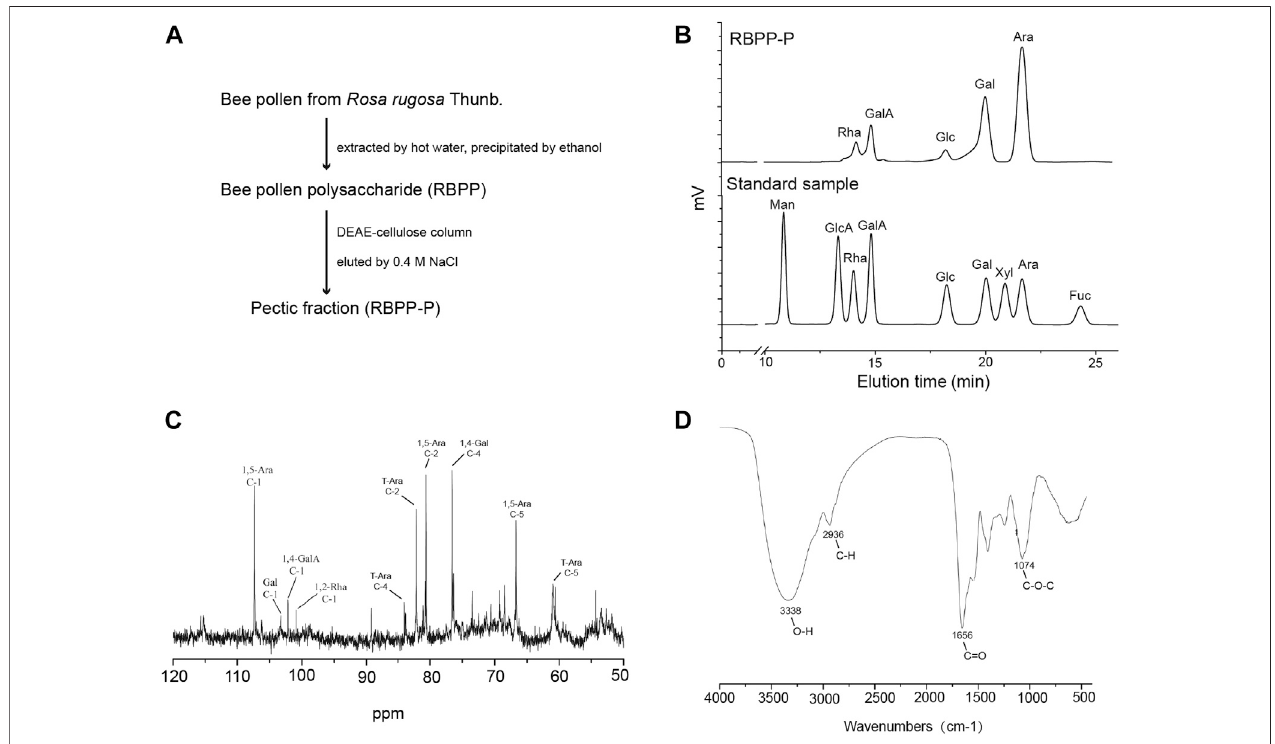
FIGURE1 | Preparation and characterization ofbee pollen polysaccharide. (A) The procedure used toprepare RBPP-P from Rosa rugosa Thunb. (Rosaceae). (B) Analysis of the monosaccharide composition of RBPP-P using high performance liquid chromatography (HPLC). (C) Analysis of chemical structure of RBPP-P using 13 C-nuclear magnetic resonance ( 13 C-NMR). (D) Analysis of the chemical structure of RBPP-P using fourier transform-infrared spectroscopy